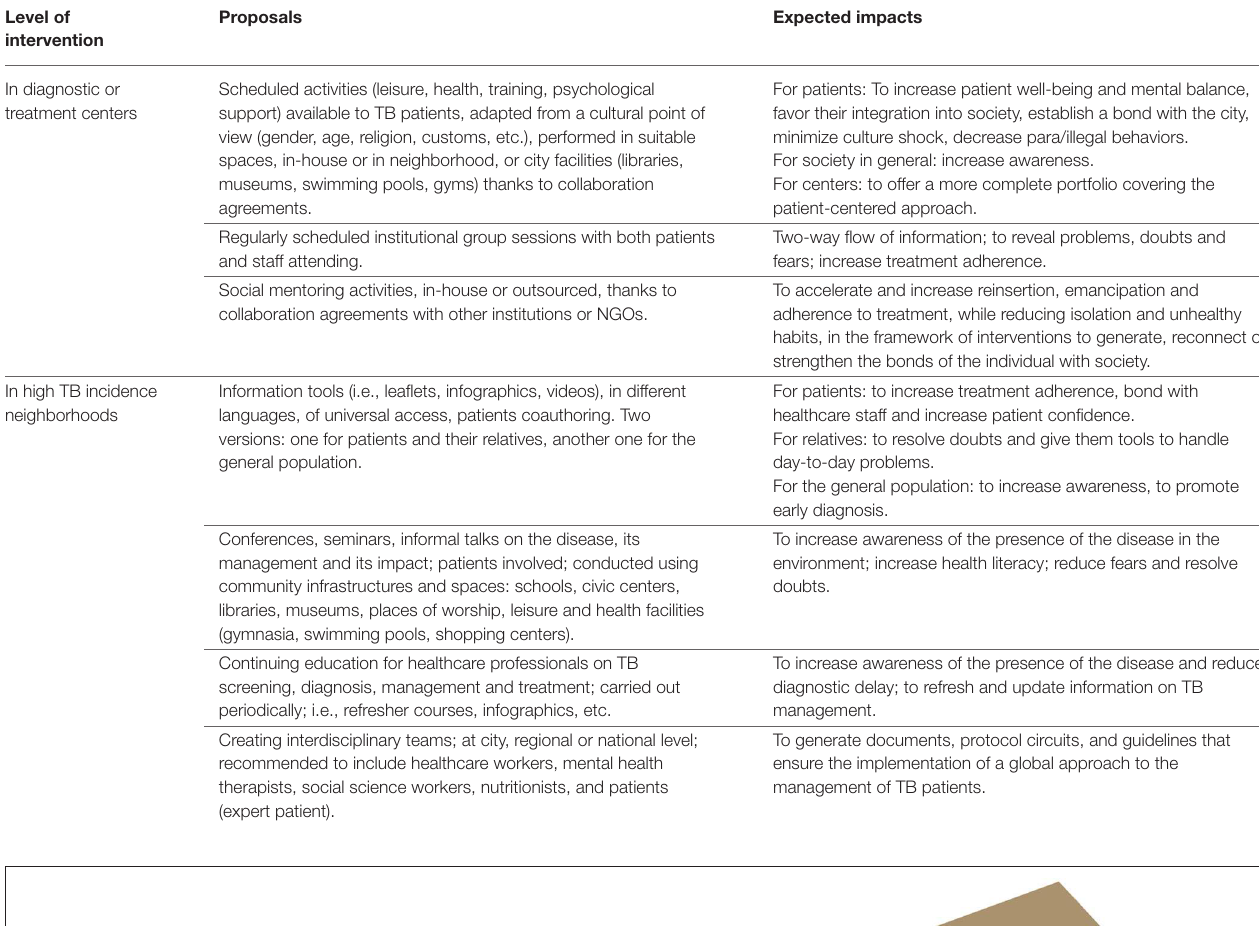
TABLE 1 | Specific interventions proposed to implement the patient-centered approach to TB care.